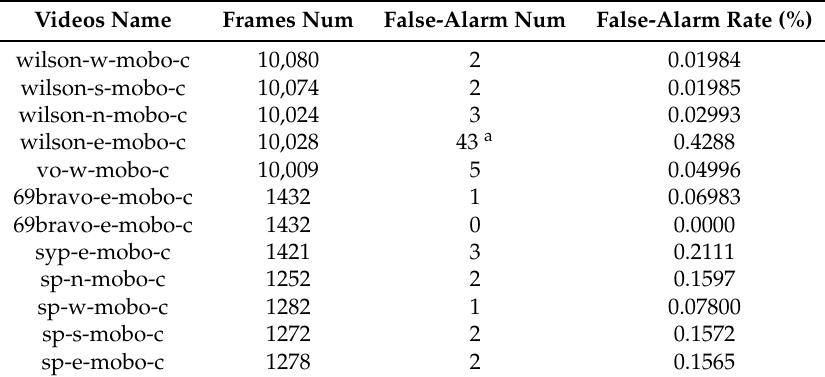
Table 4. No-Fire Video Result of HPWREN Database.